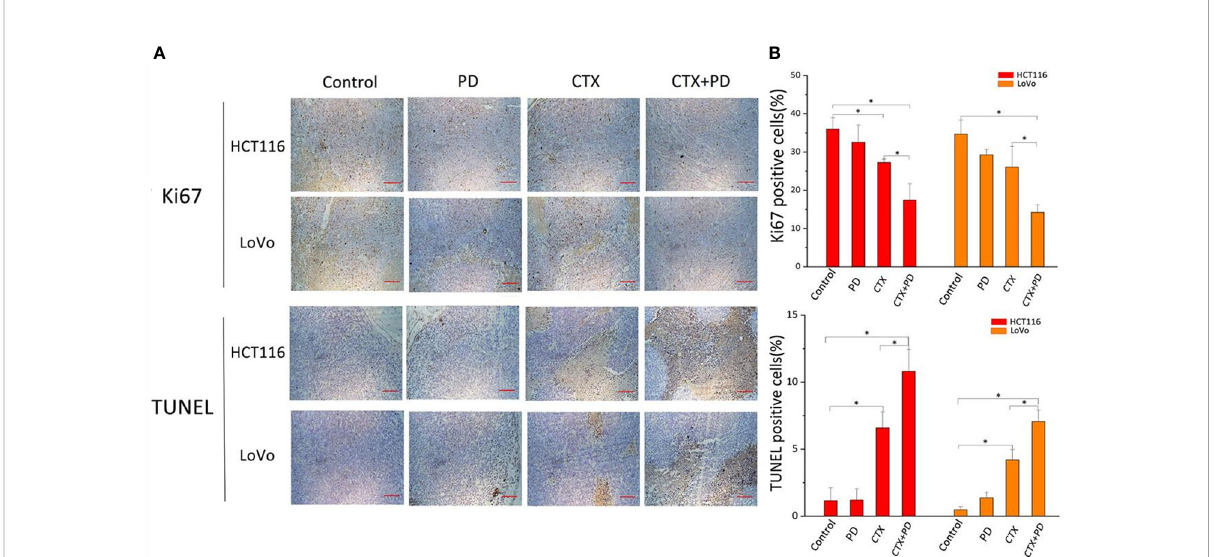
FIGURE 7 Combination treatment of CTX and PD decreases proliferation and enhance apoptosis in vivo . (A) Images of Ki67 immunohistochemical analysis and TUNEL staining assay in subcutaneous tumor models. Scale bars, 100 m m. (B) Quantitation of positive immunohistochemical staining for Ki67 and TUNEL staining in every group. Graph of percentage of positive cells for Ki67 and TUNEL staining (three random fi elds). ImageJ was used to quantify positive immunohistochemical staining results (n=3). Data are shown as the mean ± S.D. One-way ANOVA was used to analyze P values between groups. All groups are compared with the ‘ Control ’ group, and the ‘ CTX ’ group is compared with the ‘ CTX+PD ’ group. * P < 0.05 represents a signi fi cant